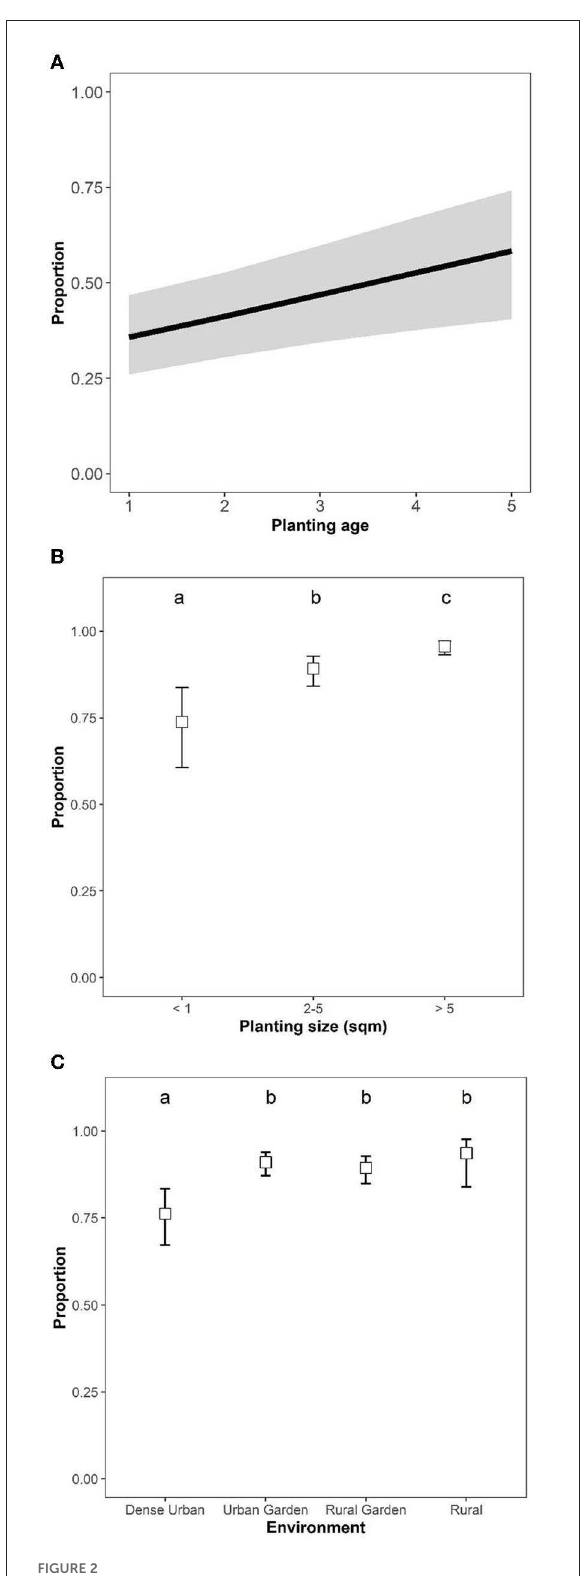
FIGURE2 The proportion of participants (estimated marginal means ± 95% confidence levels) who reported having seen “many